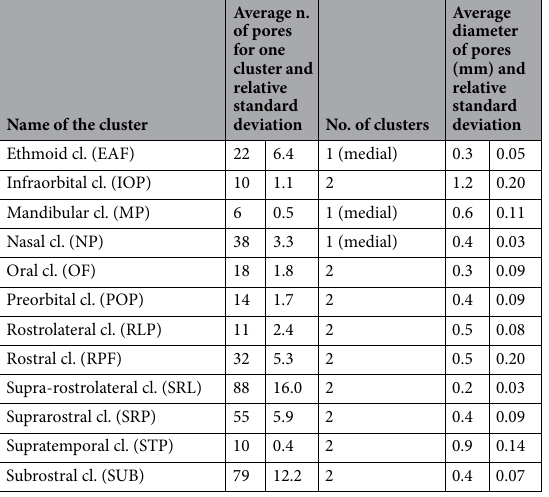
Table 1. Count and measure of ampullary pores in C. monstrosa. The average total number of pore (702 ± 103) was calculated by adding the average number for each medial cluster and the double average number for each double